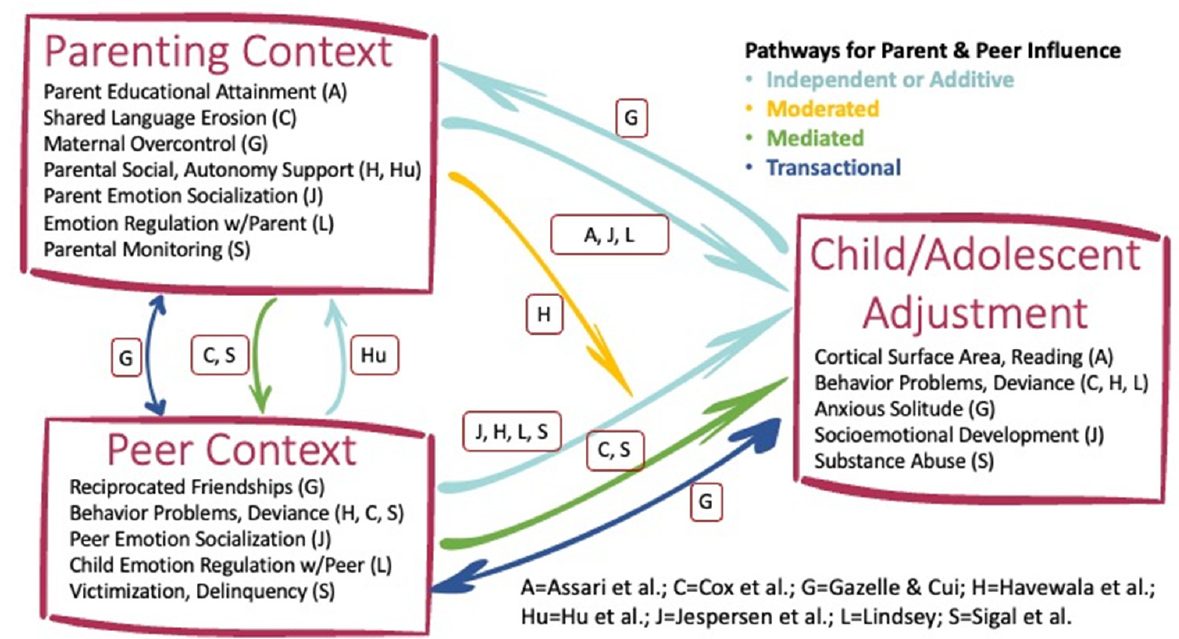
Figure 1. Pathways for parent and peer influences proposed in theoretical papers or supported empirically in this Special Issue.